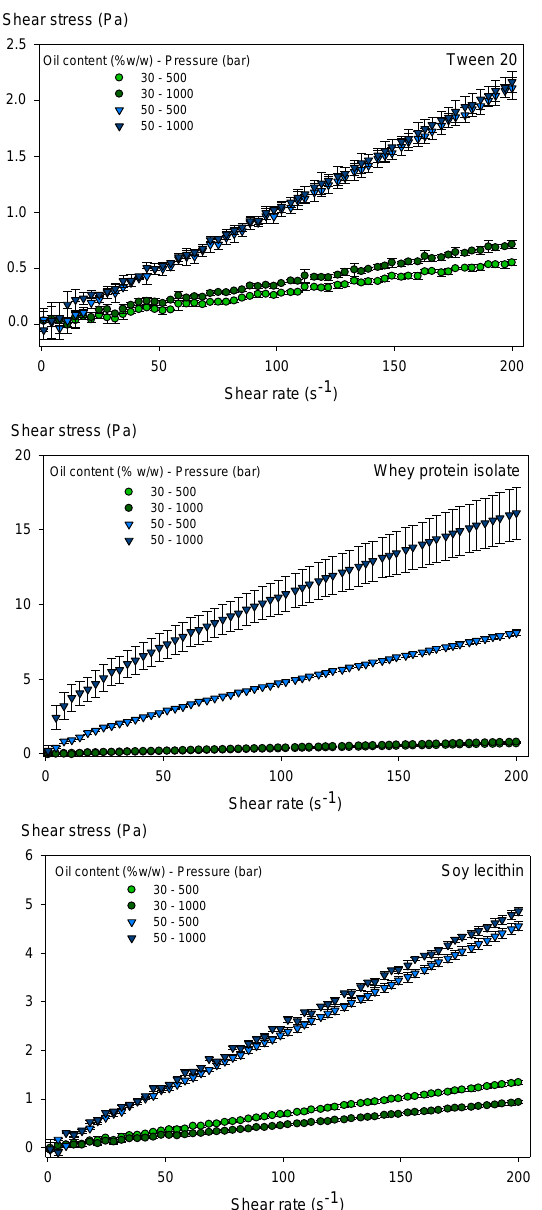
Figure 2. Rheograms for emulsions fabricated at different process conditions and stabilized by the three surfactants studied. Error bars represent one standard deviation. Table 4. Rheological parameters for the shear-thinning model for emulsions stabilized by the three surfactants studied. 1 OilContent(%